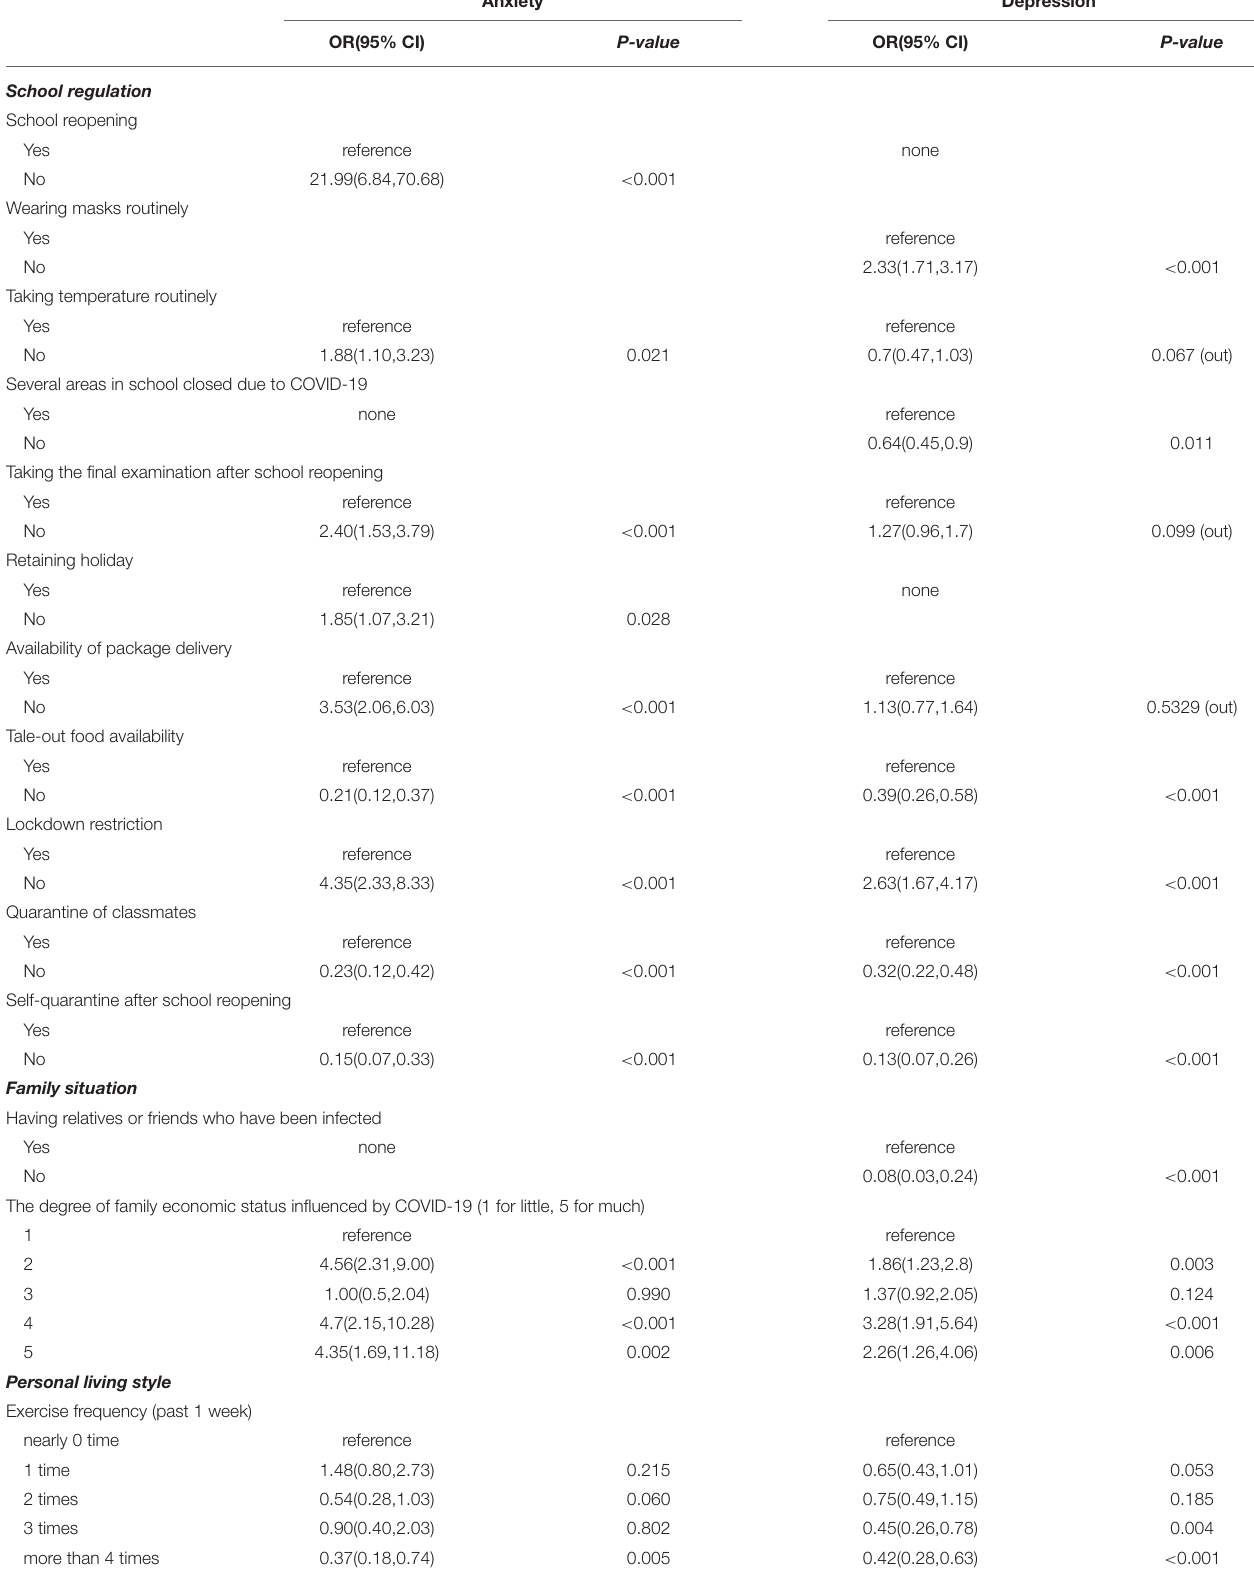
TABLE 4 | Binary logistic regression model. Anxiety Depression OR(95% CI) P-value OR(95% CI)